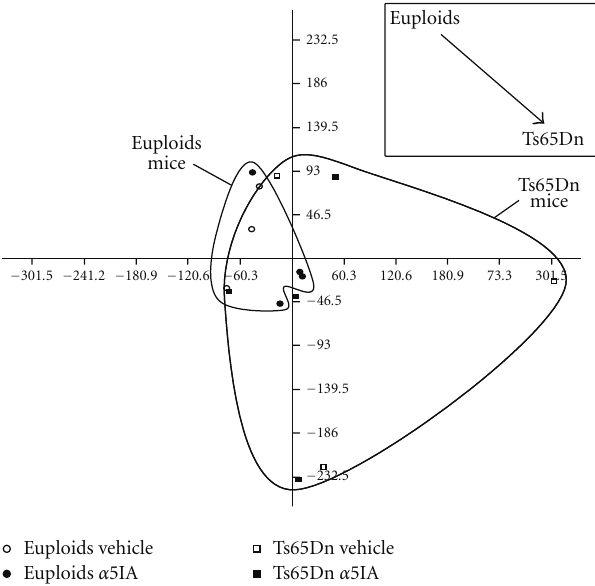
Figure 3: PCA on three-copy genes from Ts65Dn mice measured on microarrays. The first two principal components discriminated between euploid and Ts65Dn mice.